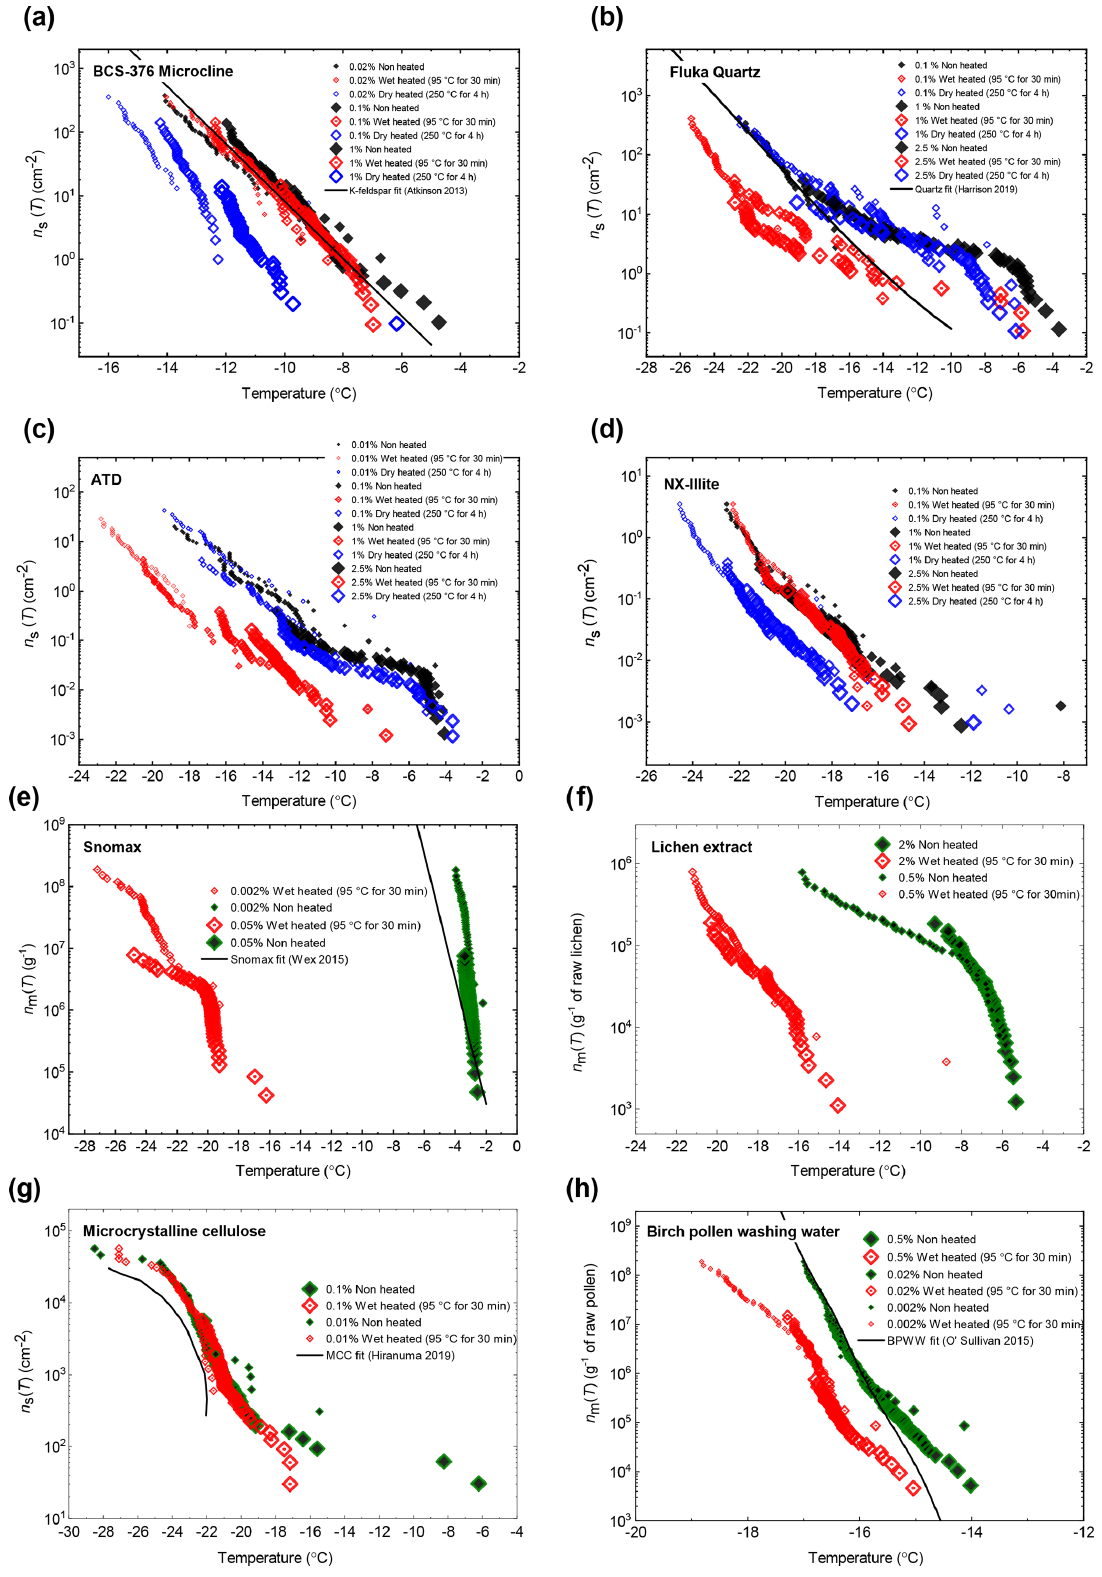
Figure B1. Plots of n s (T ) or n m (T ) illustrating heat test responses over an extended range of suspension concentrations for (a) BCS-376 microcline, (b) Fluka quartz, (c) ATD, (d) NX illite, (e) Snomax ® , (f) lichen extract, (g) MCC and (h ) birch pollen washing